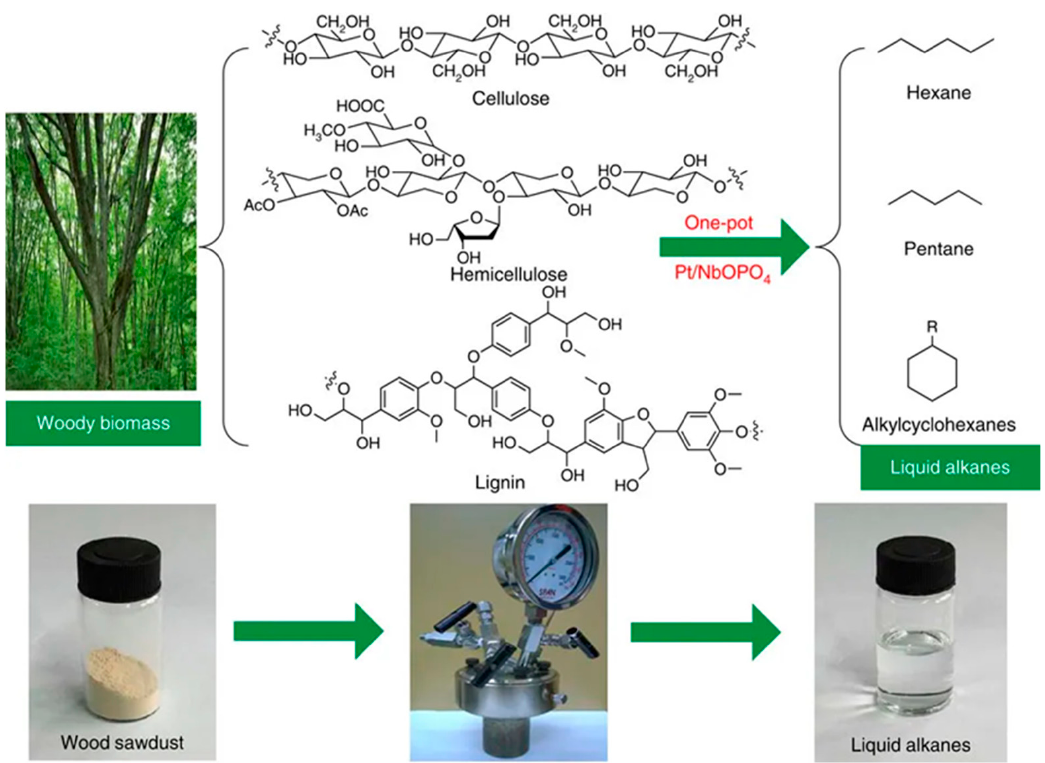
Figure 11. Direct conversion of wood cellulose, hemicellulose, and lignin fractions into hexane, pentane, and alkylcyclohexane, respectively, in the presence of NbOPO 4 /Pt catalyst in cyclohexane. Reproduced with permission from ref. [113] Copyright © 2016 Nature